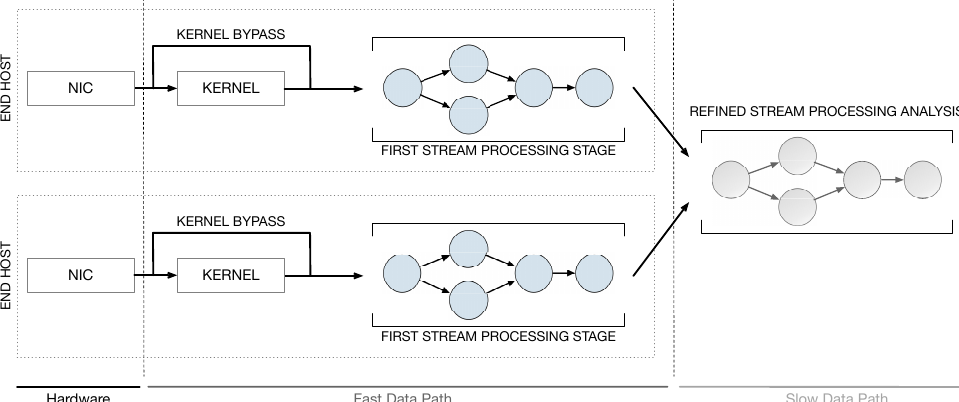
Figure 1. High-level view of the framework